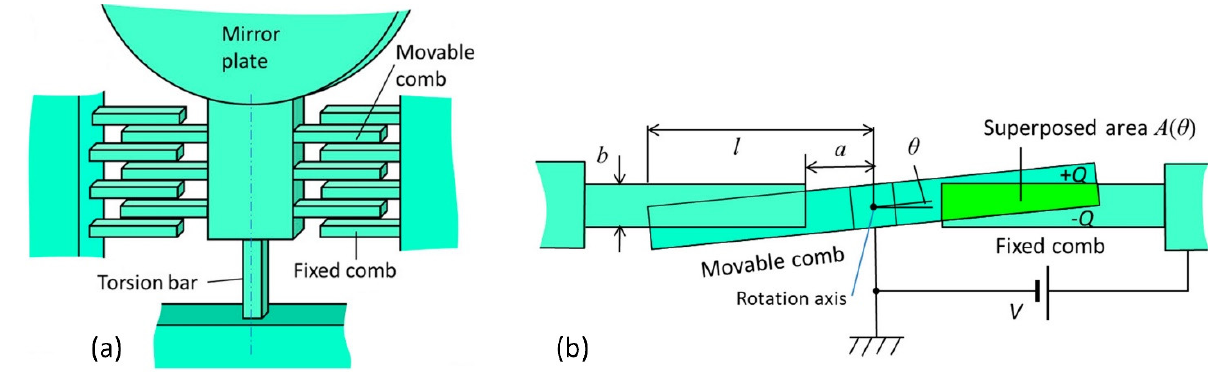
Figure 11. Schematic diagram of torsion bar with electrostatic spring consisting of comb electrodes: ( a ) side view; ( b ) top view; b—thickness; l—the distance between the rotation axis and the end of movable comb finger; a—the distance from the rotation axis to the end of fixed comb finger; θ — rotation angle. Adapted from [89].